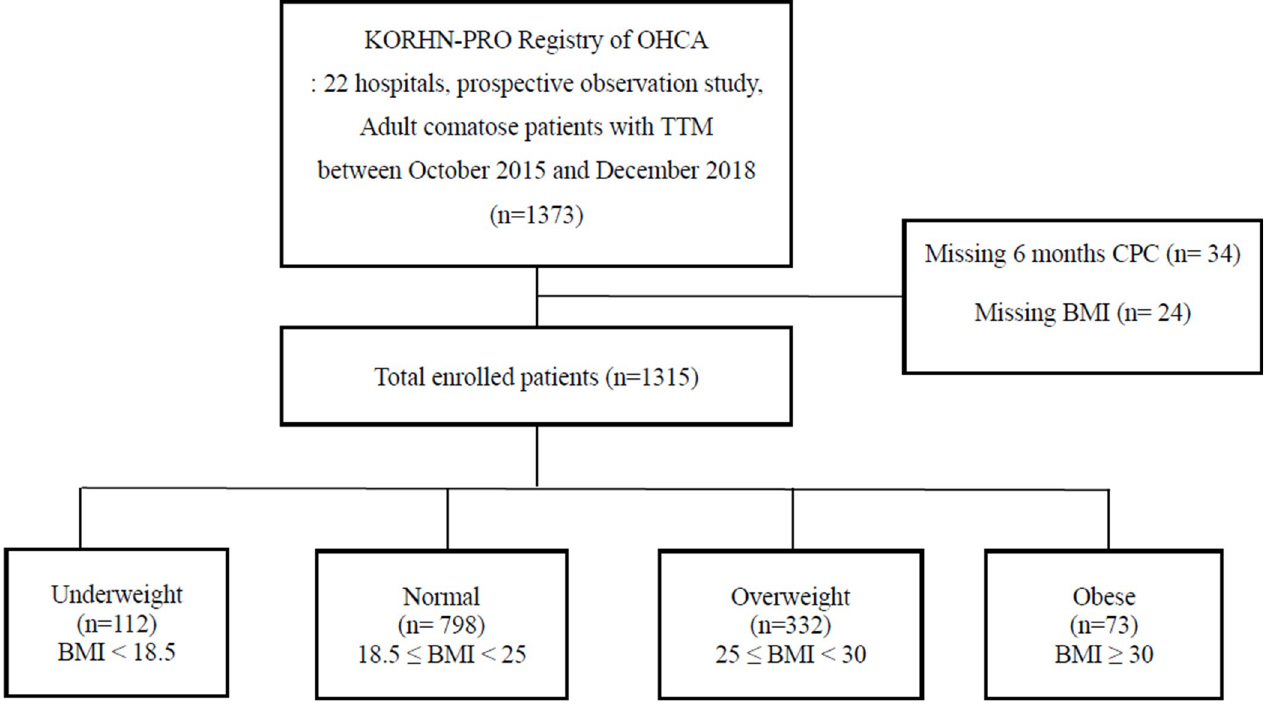
Fig 1. Flow chart of the study. Abbreviation : OHCA out-of-hospital cardiac arrest, TTM targeted temperature management, BMI body mass index.